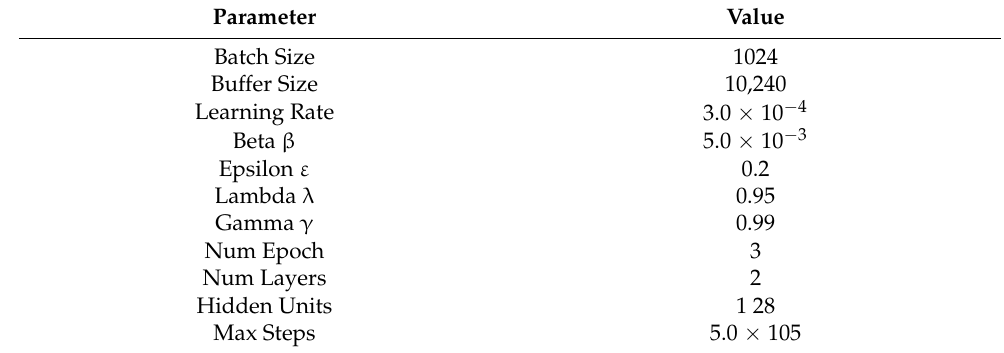
Table 3. Training parameter